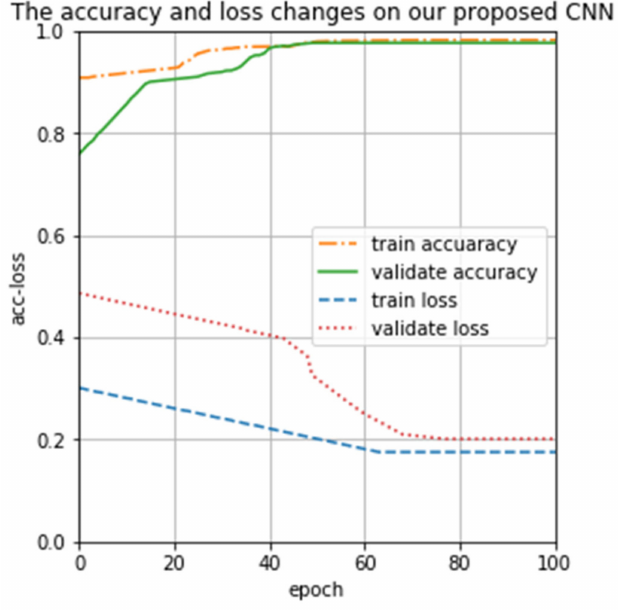
Figure 9. Proposed CNN iteration training change